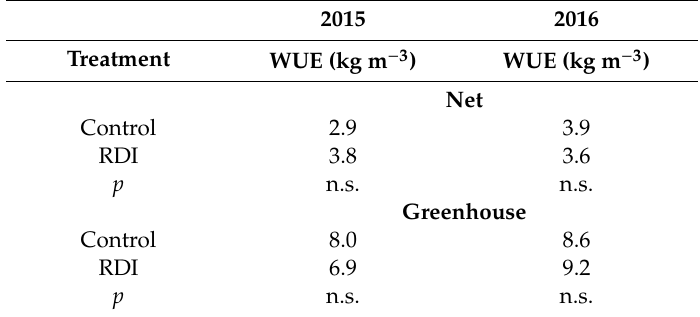
Table 4. Water use e ffi ciency (WUE) for the irrigation treatments in vines grown under net and under plastic greenhouse, in 2015 and 2016. (n.s.: nonsignificant, Student’s t test p < 0.05)